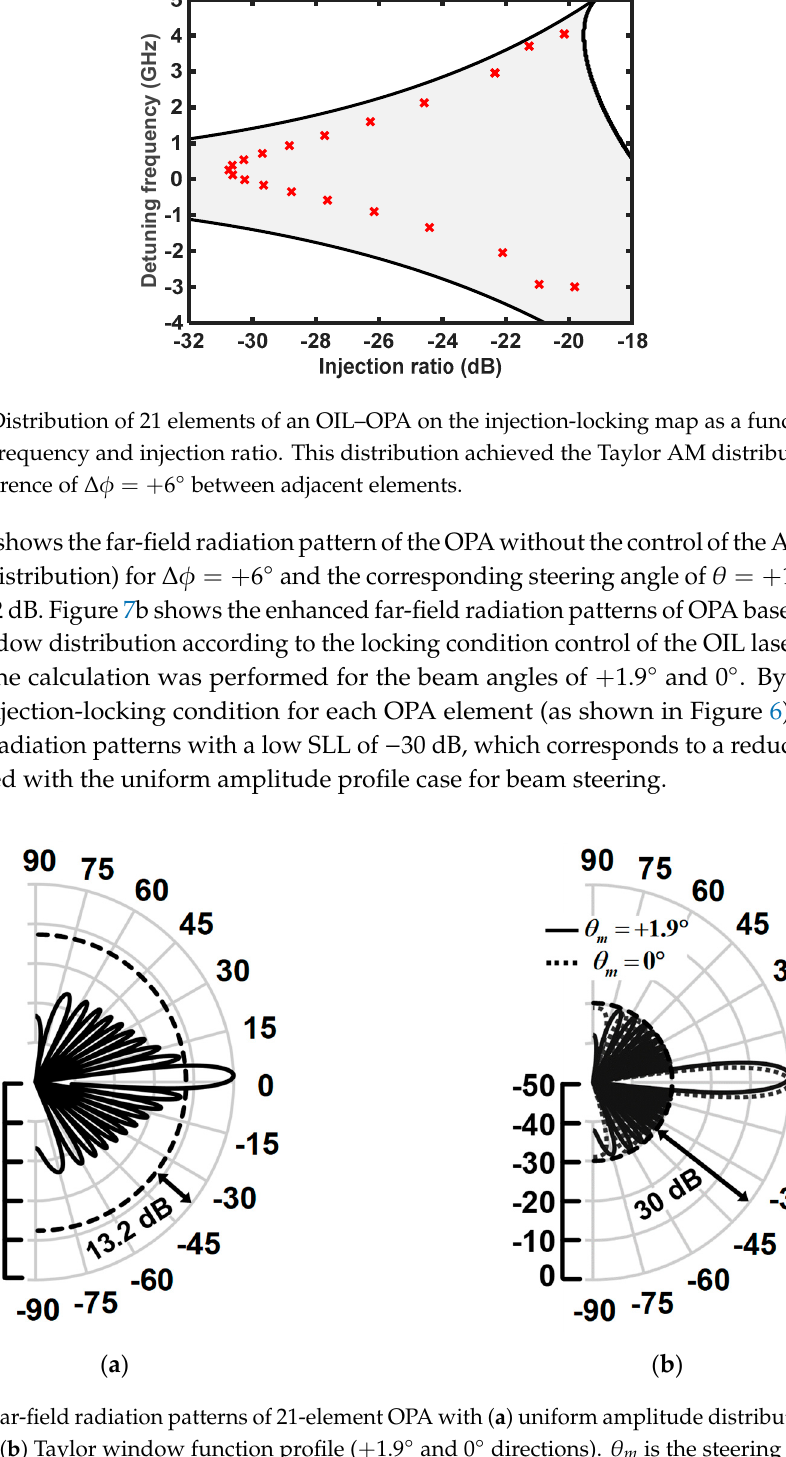
 is the steering m